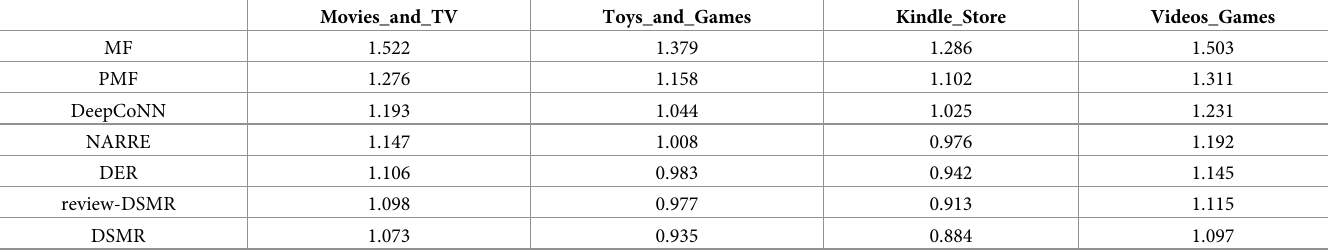
Table 2. Performance comparison without data equal control